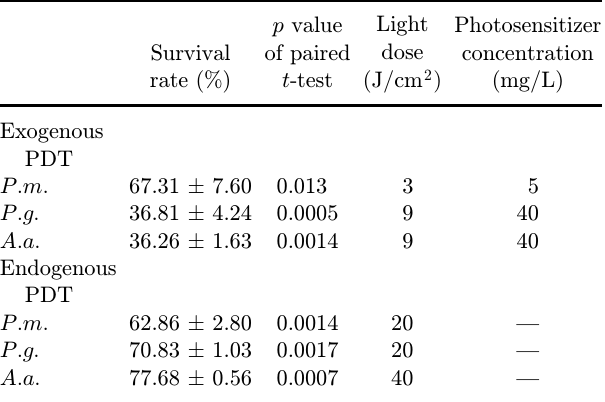
Table 1. Best exogenous and endogenous PDT e®ects of three pathogenic bacteria of periodontitis.